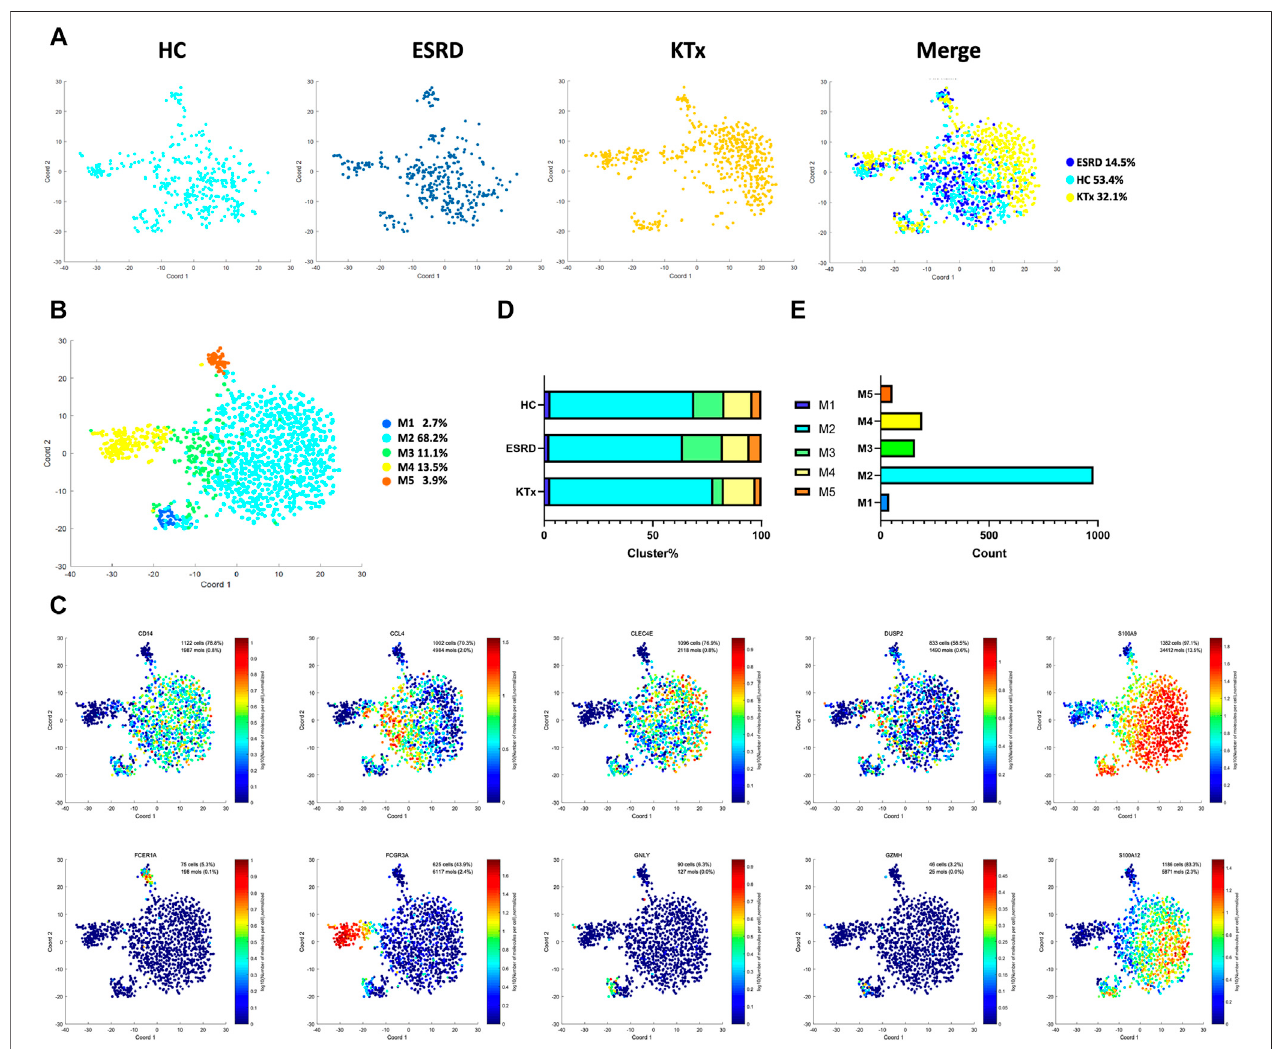
FIGURE4| MyeloidclustersinPBMCsfromHC,ESRD,andKTx. (A,B) tSNE ofsingle-cellpro fi lewitheachcellcolorcodedformyeloidsubsets. (C) Expressionof highly expressed genes in each myeloid cluster. (D) Proportion of 5 myeloid subsets. (E) Cell count of 5 myeloid subsets.